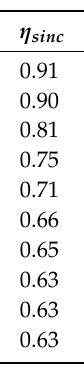
Figure A3. Behavior of f a ( η , η o ) / φ (cid:48) a ( η , η o ) , f − a ( η , η o ) / φ (cid:48) − a ( η , η o ) , and − a / [ z 2 o dx η for η o = 0.631 ( x o = 7.5 λ ) , and η o = 0.921 ( x o = 15 λ ) .